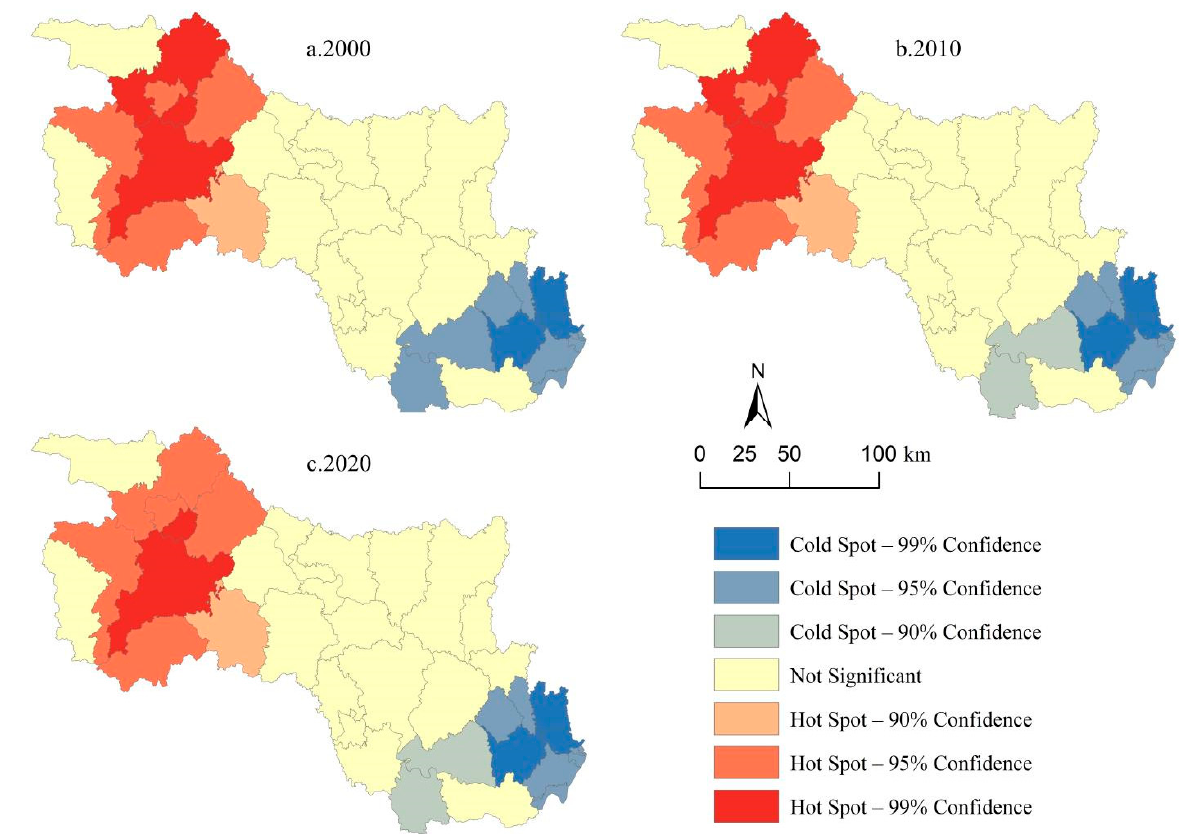
Figure 6. Spatial agglomeration characteristics of ESV in the HRB of Hubei Province for ( a ) 2000, ( b ) 2010, and ( c ) 2020.